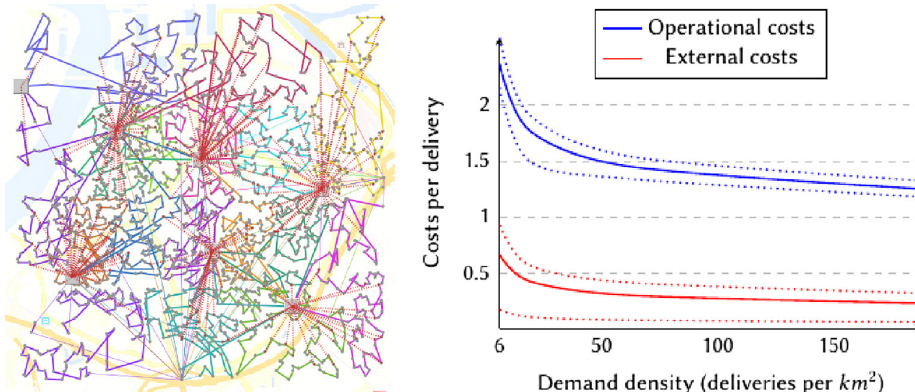
Fig. 3 (left) Routes for high demand are computed by clustering the customers, and serving each cluster by a separate tour, as indicated by the different colours. (right) Costs per delivery as a function of demand, the dotted lines below and above present free-flow (26 km/h) and heavy congestion (13 km/h),